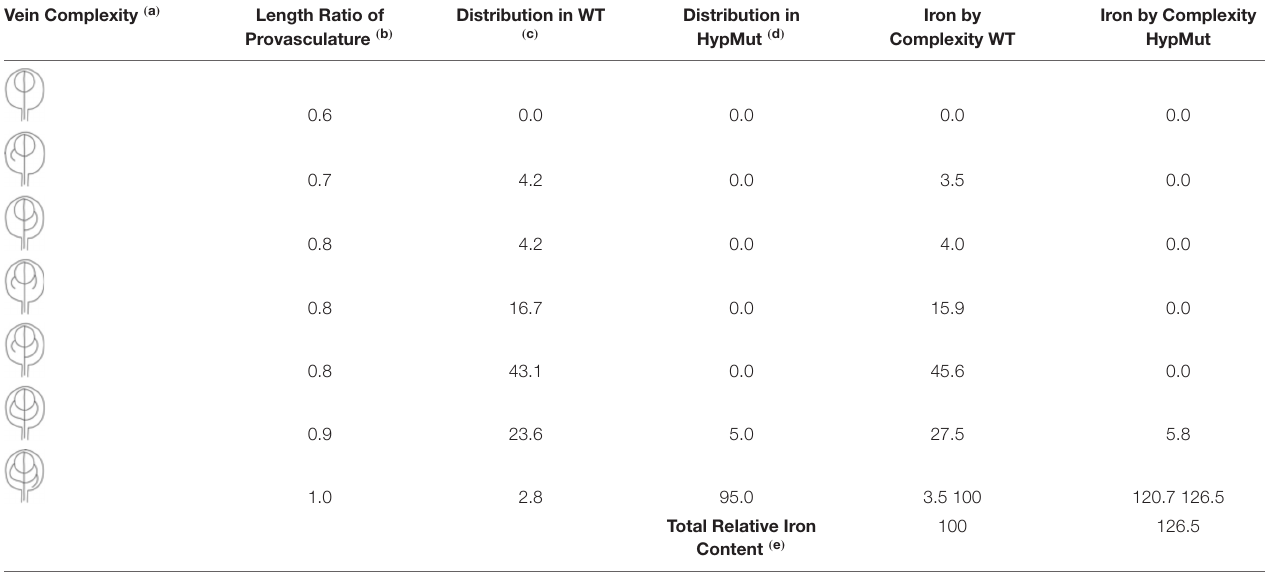
TABLE 1 | Estimation of iron increase in cotyledons with high provasculature complexity. Vein Complexity ( a ) Length Ratio of Provasculature ( b